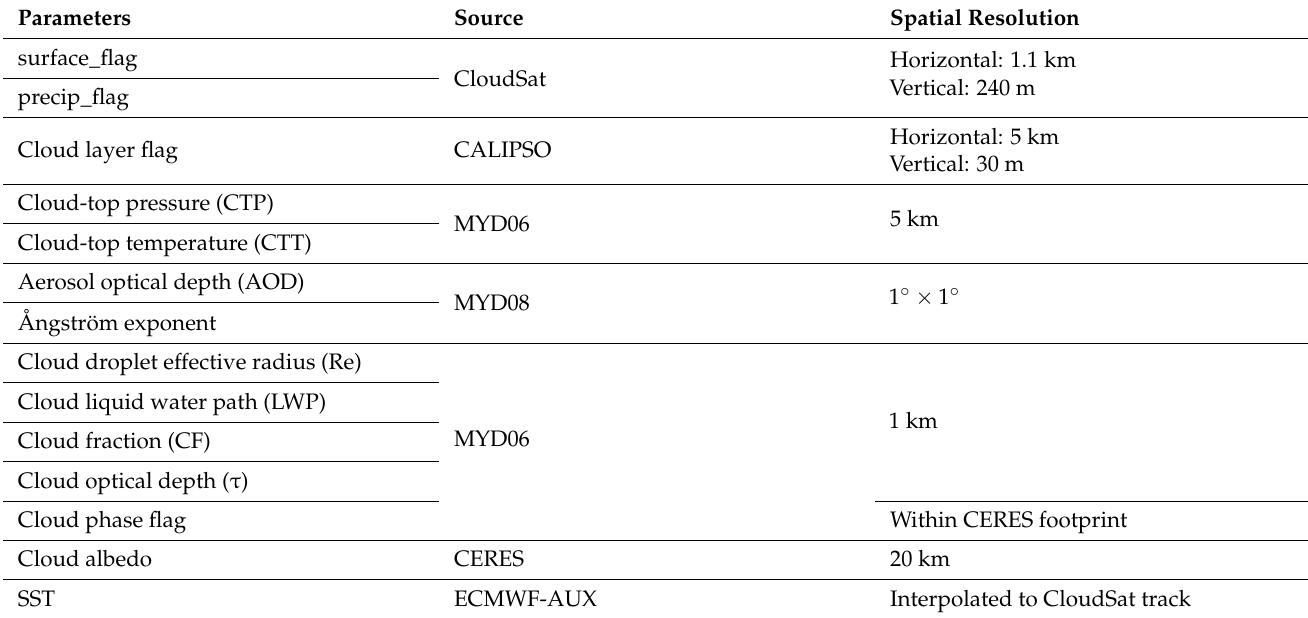
Table 1. The list of satellite data applied in this study, including the observations from CloudSat, MODIS, CALIPSO, CERES, and